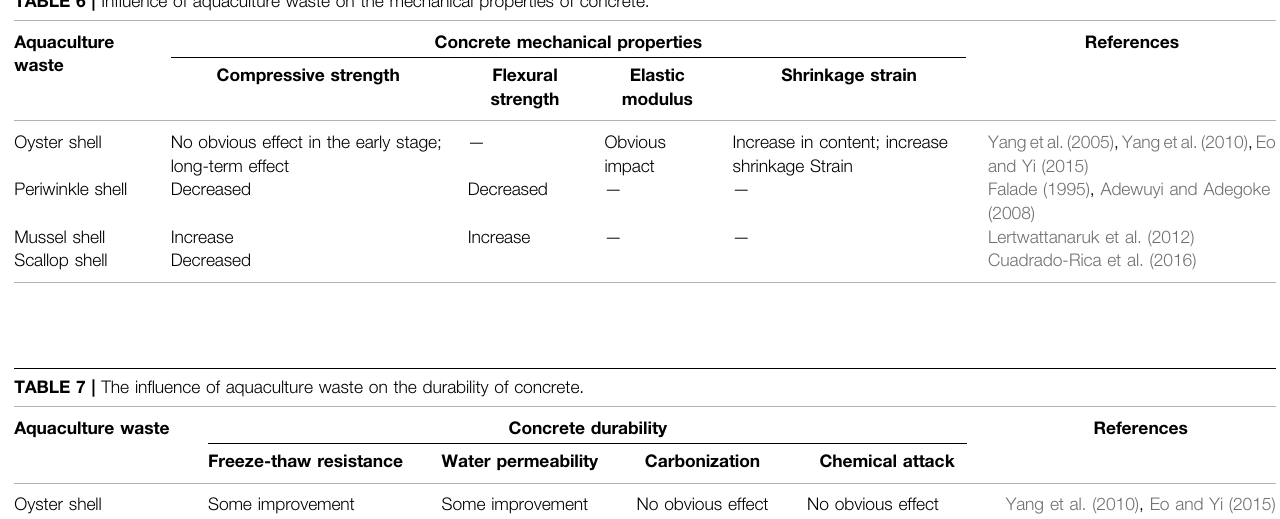
TABLE 6 | In fl uence of aquaculture waste on the mechanical properties of concrete.